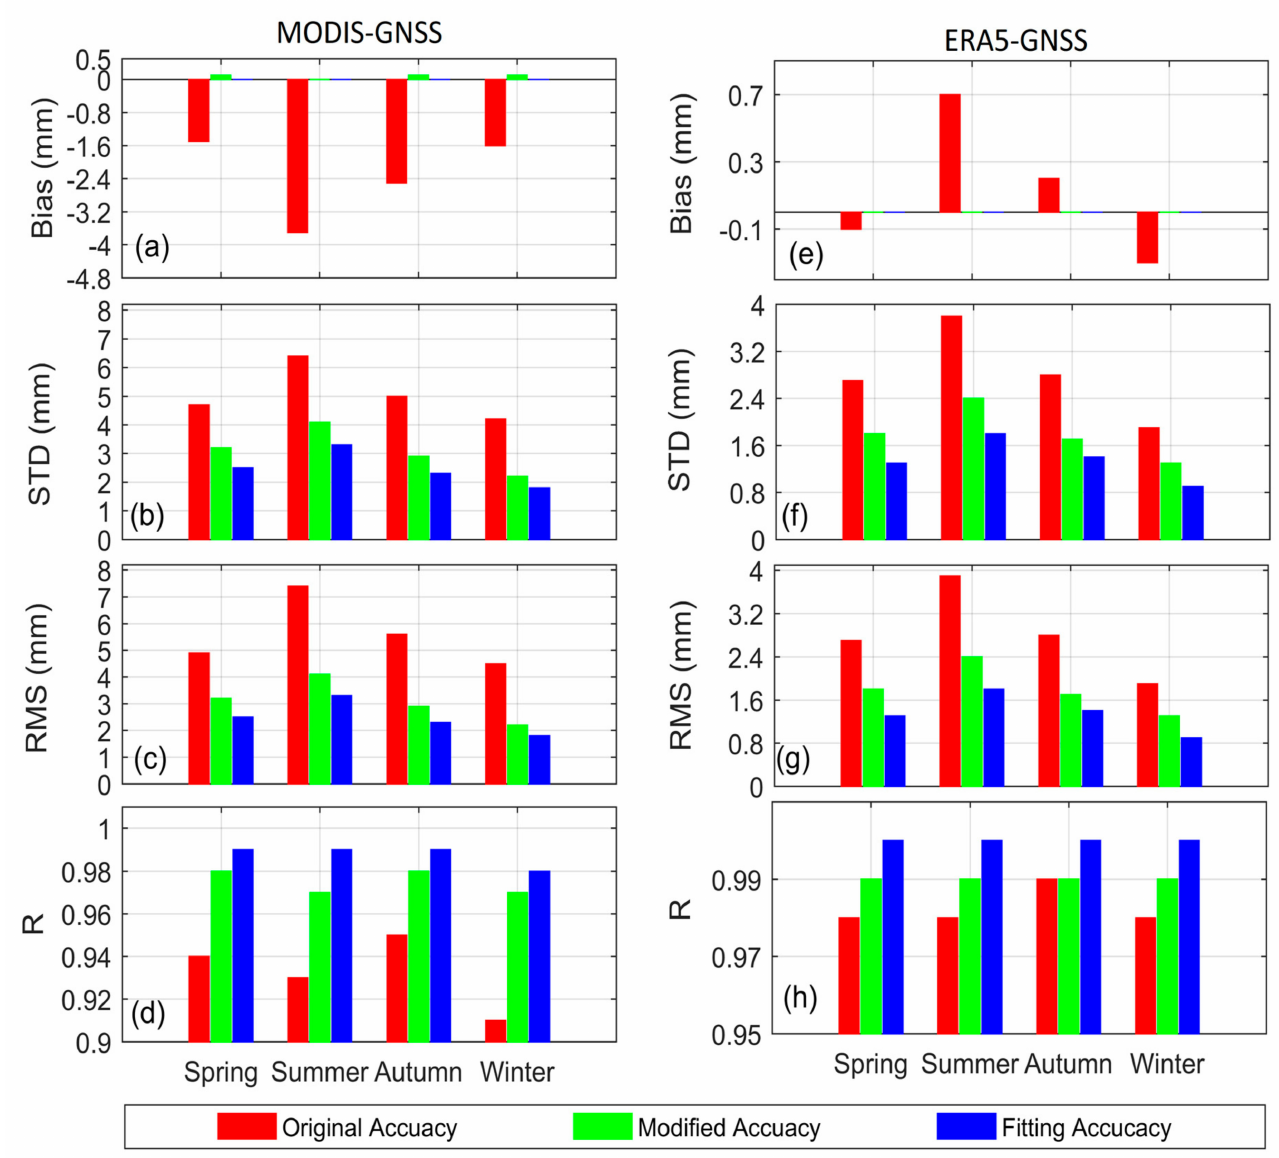
Figure 4. Accuracy information of the quarterly models in different seasons. ( a ) Bias of the MODIS-GNSS model; ( b ) STD of the MODIS-GNSS model; ( c ) RMS of the MODIS-GNSS model; ( d ) R of the MODIS-GNSS model; ( e ) Bias of the ERA5-GNSS model; ( f ) STD of the ERA5-GNSS model; ( g ) RMS of the ERA5-GNSS model; ( h ) R of the ERA5-GNSS